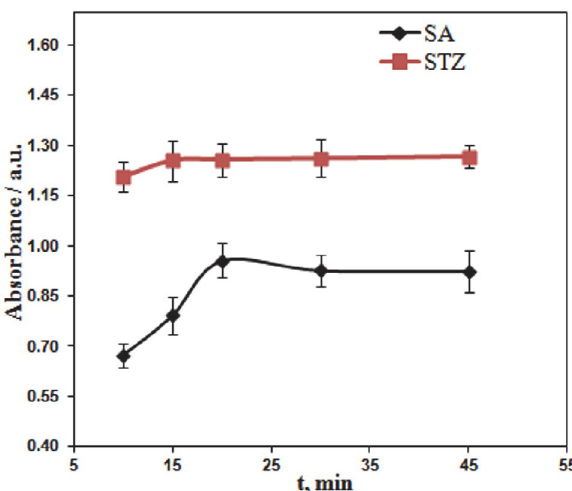
Fig. 4. Effect of time of the SA and STZ diazotization on the yield of the product of theirs interaction with AM. 1. C SA = 2.0 . 10 –4 M, C HCl = 0.6 M; 2. C STZ = 2.0 . 10 –4 M, C HCl = 0.7 M; C AM = 5.0 . 10 –5 M, C